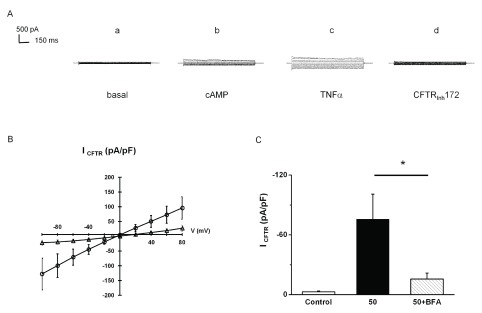
Stimulation of F508del-CFTR activity by 50 ng/ml TNFα is blocked by BFA.Whole cell Cl
- currents recorded in HeLa cells expressing F508del-CFTR by patch-clamp experiments. * indicates significant results.
A. Representative current traces recorded by holding the membrane potential at 0 mV and by pulsing the voltages in the range -100 mV to +80 mV at 20 mV steps for cells treated by 35 µM brefeldin A (BFA) for 2h. Current traces recorded: at the basal level (
a); in the presence of CPT-cAMP/IBMX (
b); in the presence of 50 TNFα+CPT-cAMP/IBMX (
c); in the presence of CFTR
Inh172+50 TNFα+CPT-cAMP/IBMX (
d).
B. Mean CFTR-related current-voltage relationships. Current densities normalized to cell capacitance (pA/pF) were measured in the presence of TNFα (
O); on cell treated for 2h by 35µM brefeldin A in the presence of TNFα (Δ).
C. Mean CFTR current amplitudes recorded at -60 mV and normalized to cell capacitance in untreated cells (control; mean + SEM; n=8), in cells treated for 10 minutes by TNFα (50; mean + SEM, n=8) and in cells treated by 35 µM brefeldin A for 2h and for 10 minutes by TNFα (50+BFA; means + SEM, n=6). Statistics: unpaired Student’s t test between (50) and (50 + BFA), p=0.025.